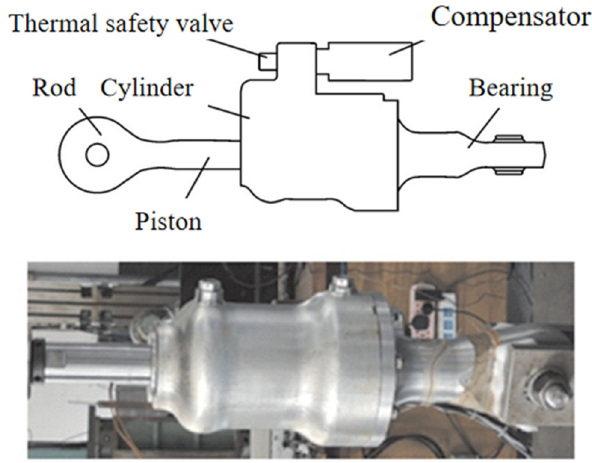
Figure 17. Helicopter rotor magnetorheological damper [110].